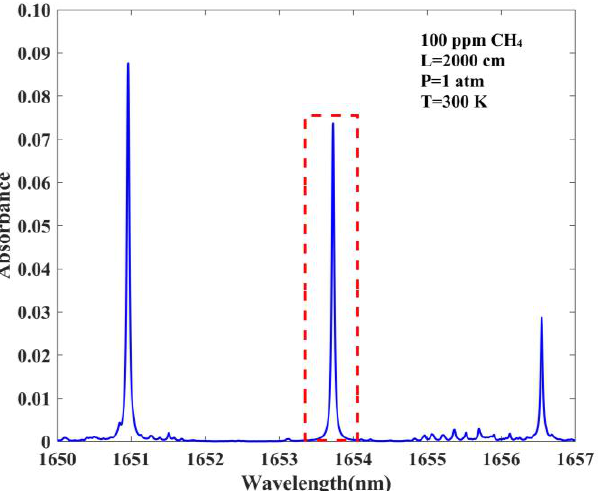
Figure 1 are as follows: temperature T = 300 K, pressure P = 1 atm, and optical path length L= 2000 cm.